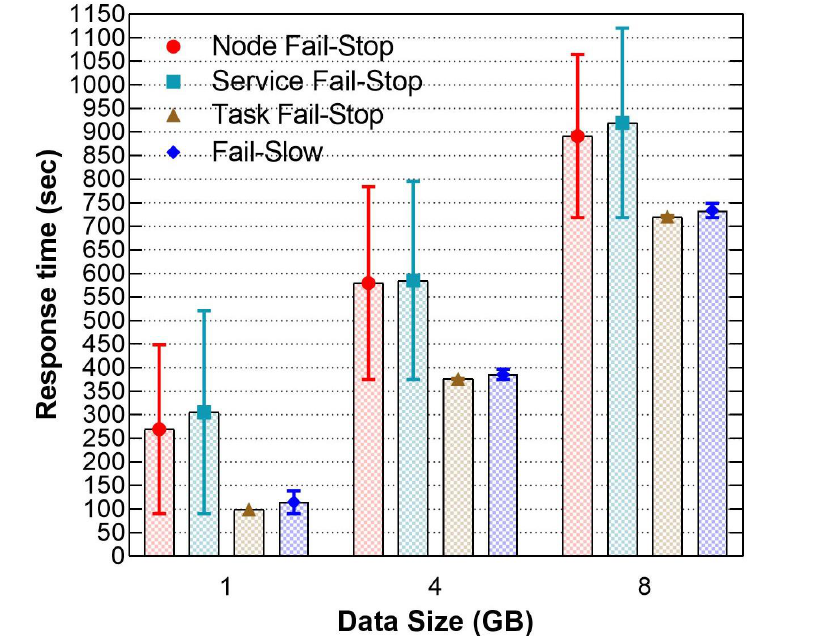
Figure 5. The response times differences when increasing dataset